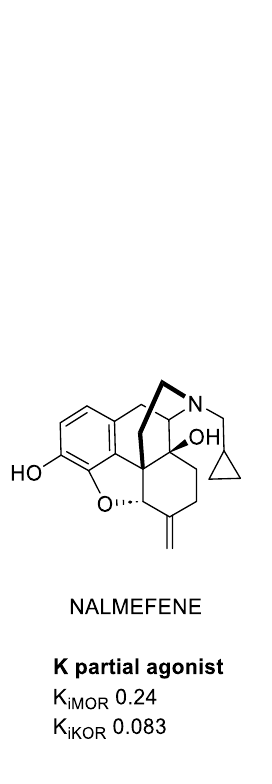
Figure 1. Examples of relevant morphinans and benzomorphans. K i values are also shown (nM).